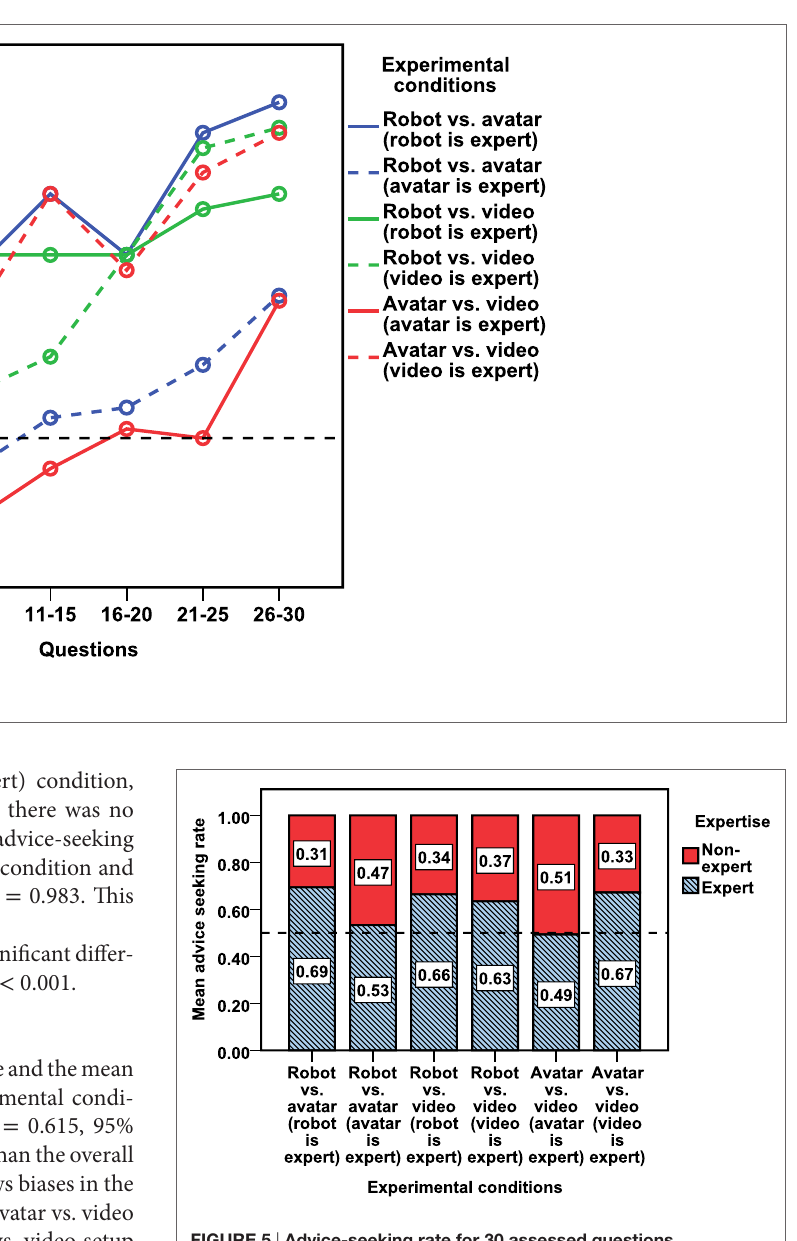
FigUre 5 | advice-seeking rate for 30 assessed questions .